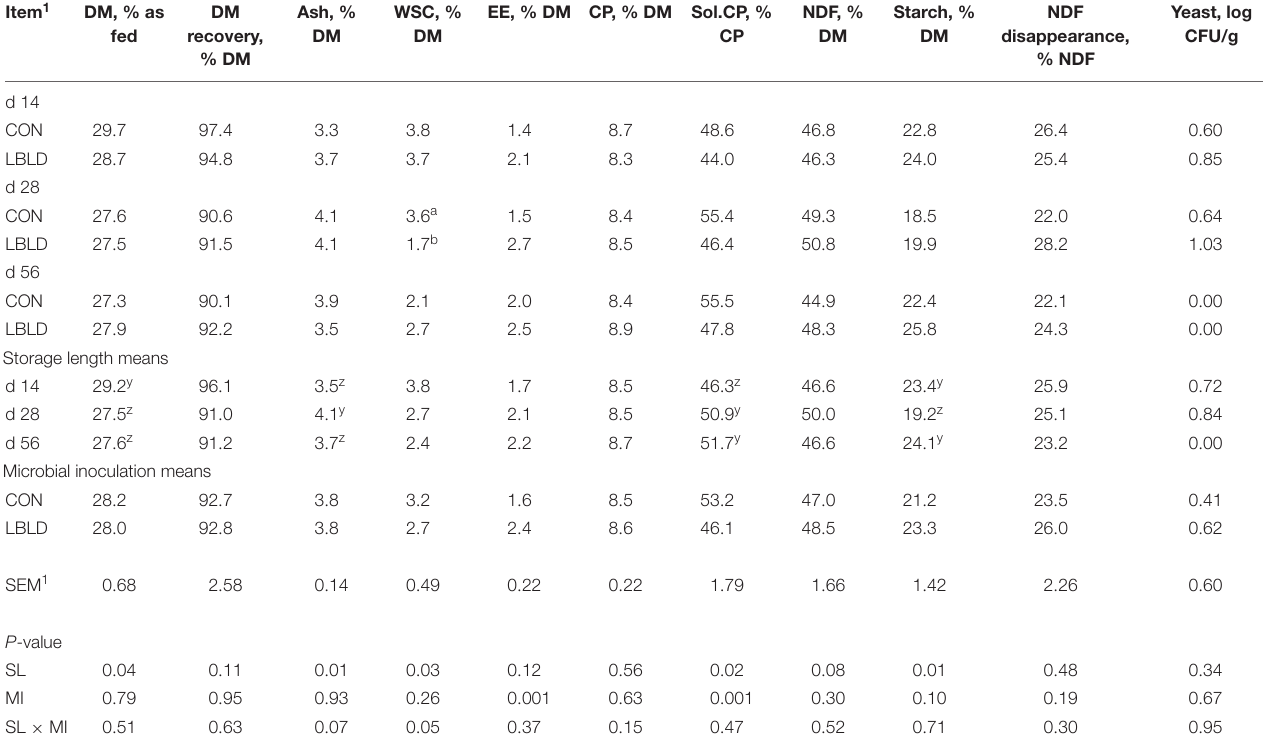
TABLE 5 | Effect of microbial inoculation and storage length on the nutrient composition and yeast counts of whole-plant forage sorghum silage in experiment